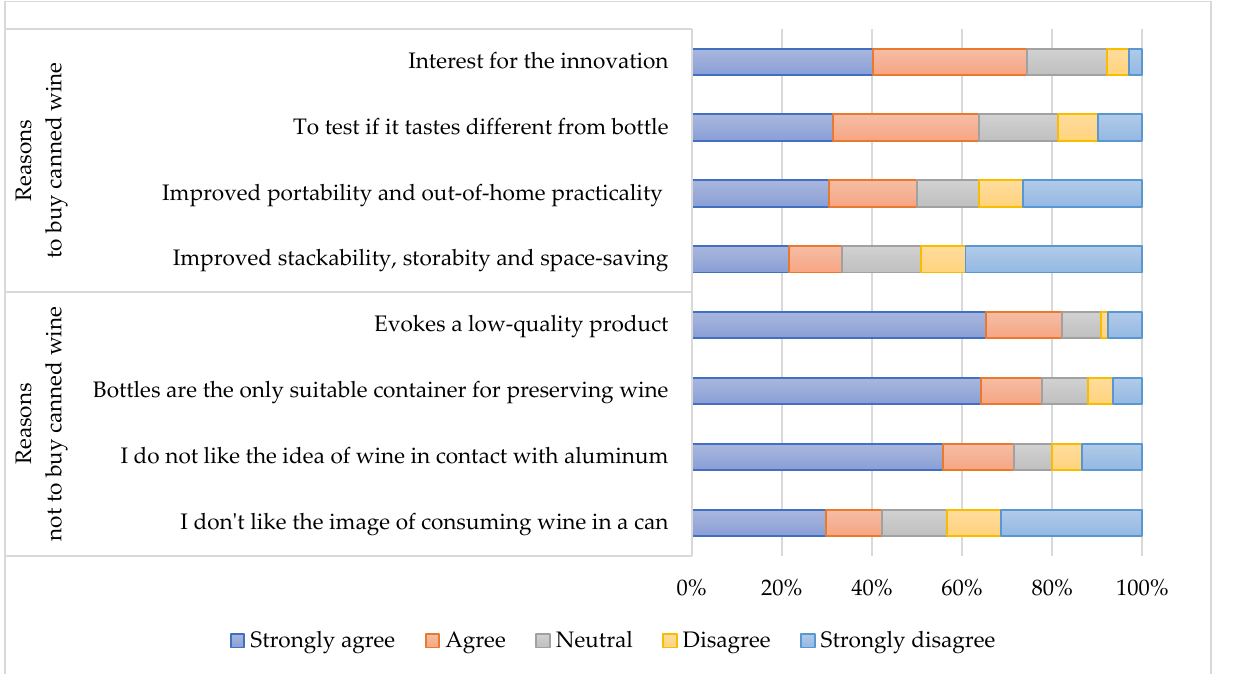
Table 3 . Zero Inflated Ordered probit results .